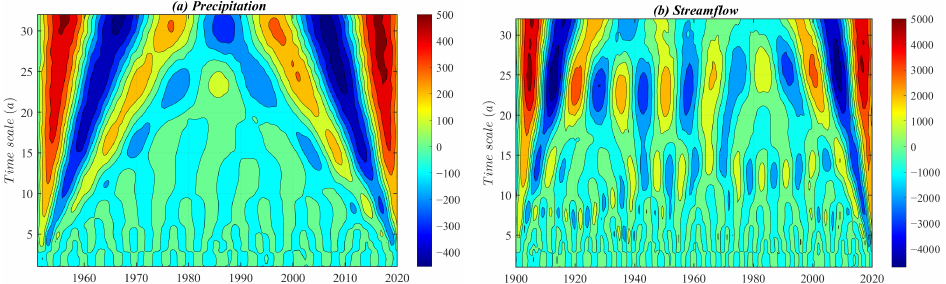
Figure 4. Wavelet coefficient contour maps of annual precipitation and streamflow series. ( a ) Precipi- tation (1951–2020); ( b ) Streamflow